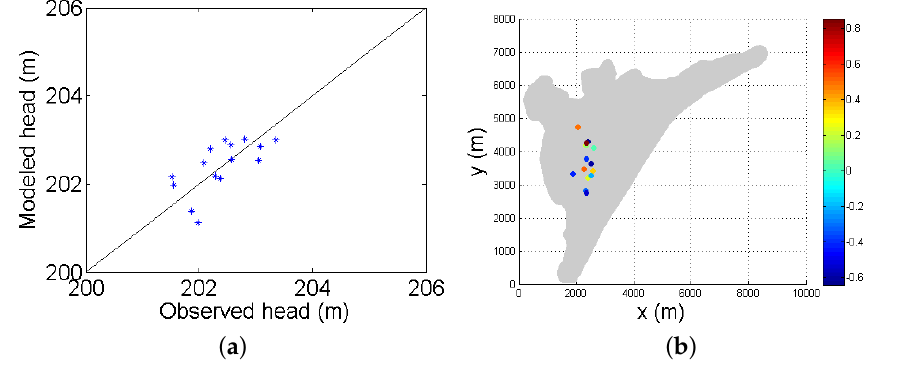
Figure 9. Model validation against hydraulic observation wells; ( a ) scatter plot between measured and modeled head (m); ( b ) localization of validation wells, color represents the bias for each well in